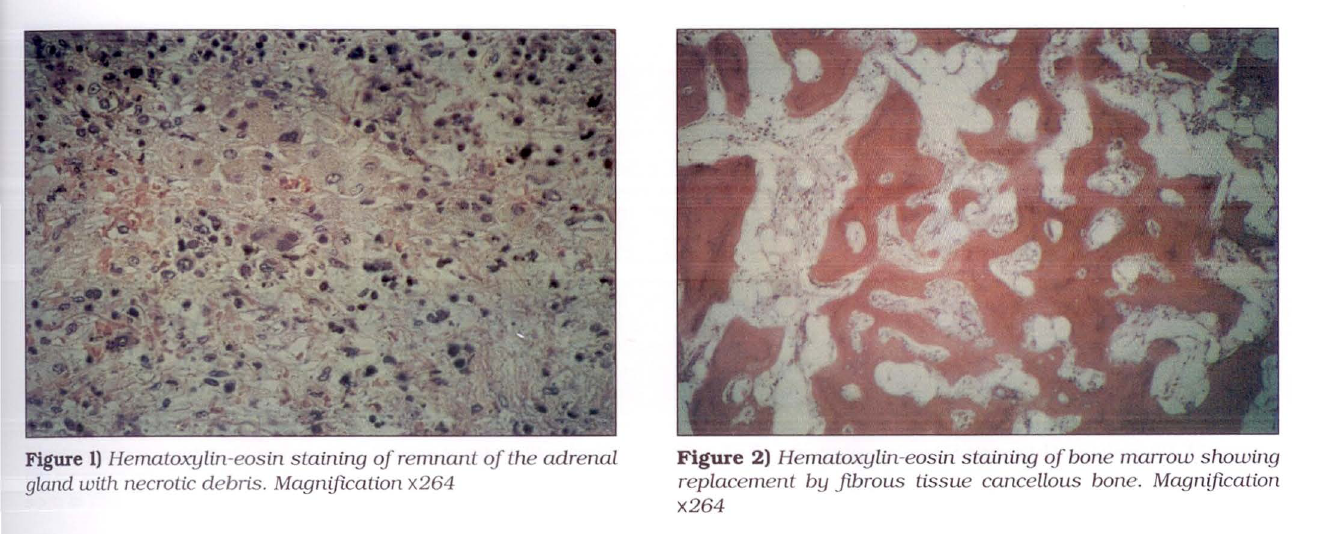
Figure 1) Hematoxylin-eosin staining of remnant of the adrenal gland with necrotic debris. Magnijication x264